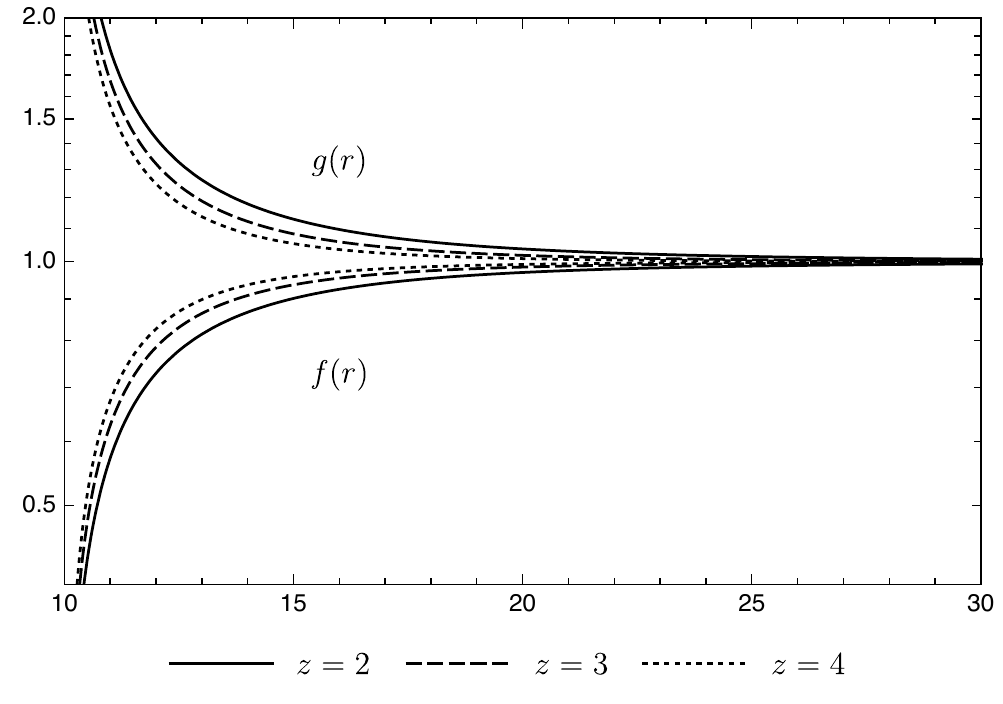
Figure 2 . The figure shows the metric functions f ( r ) and g ( r ) as a function of radius r with R 0 = 10 .